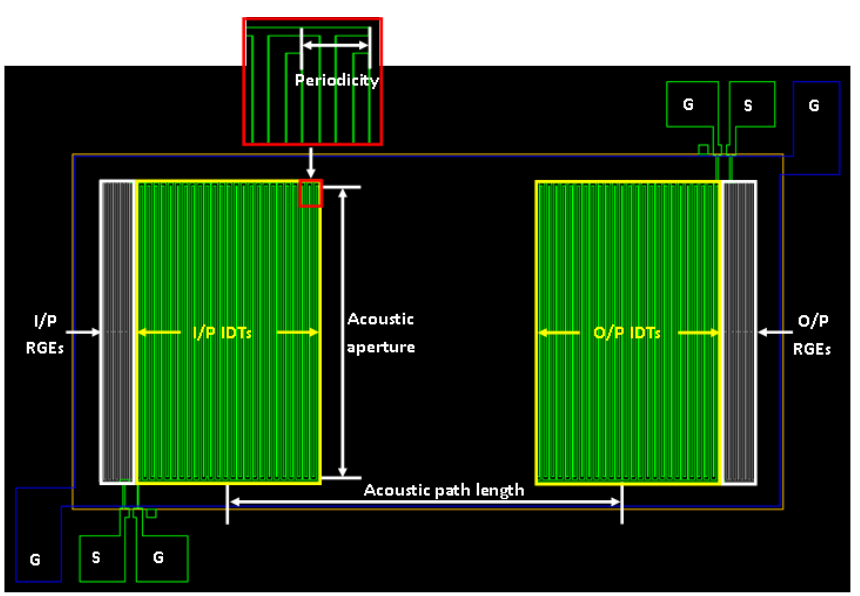
Figure 3. Layout of the FPW biosensor with grating electrode